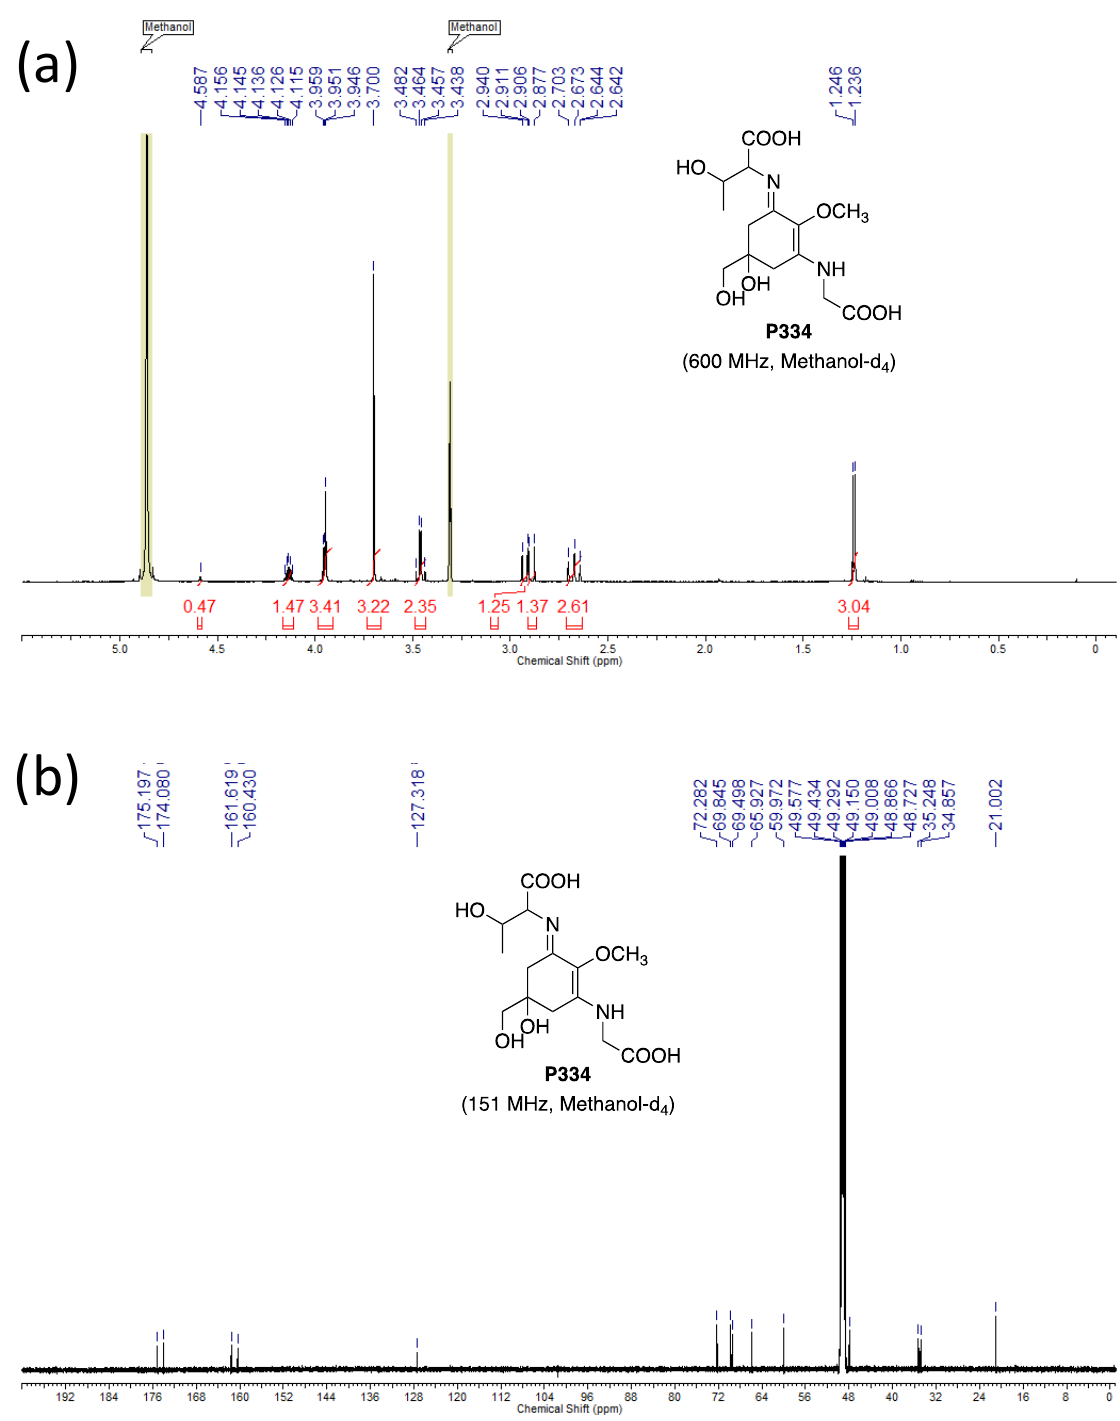
Figure 6. NMR spectra of P334. ( a ) 1 H NMR and ( b ) 13 C NMR spectra are shown.